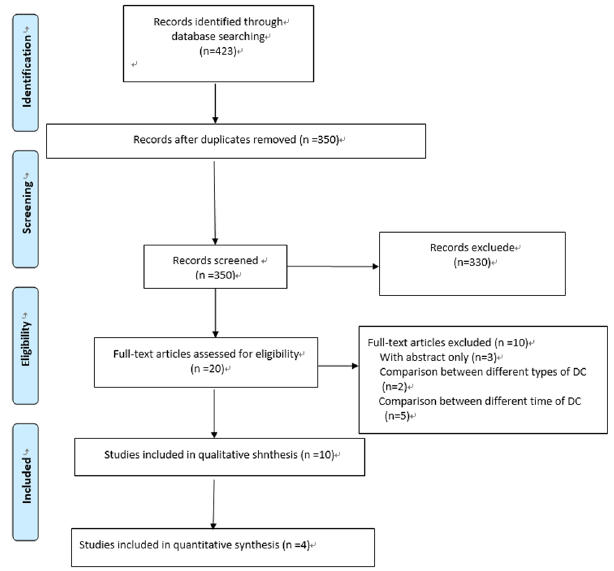
Figure 1. Flow diagram of study